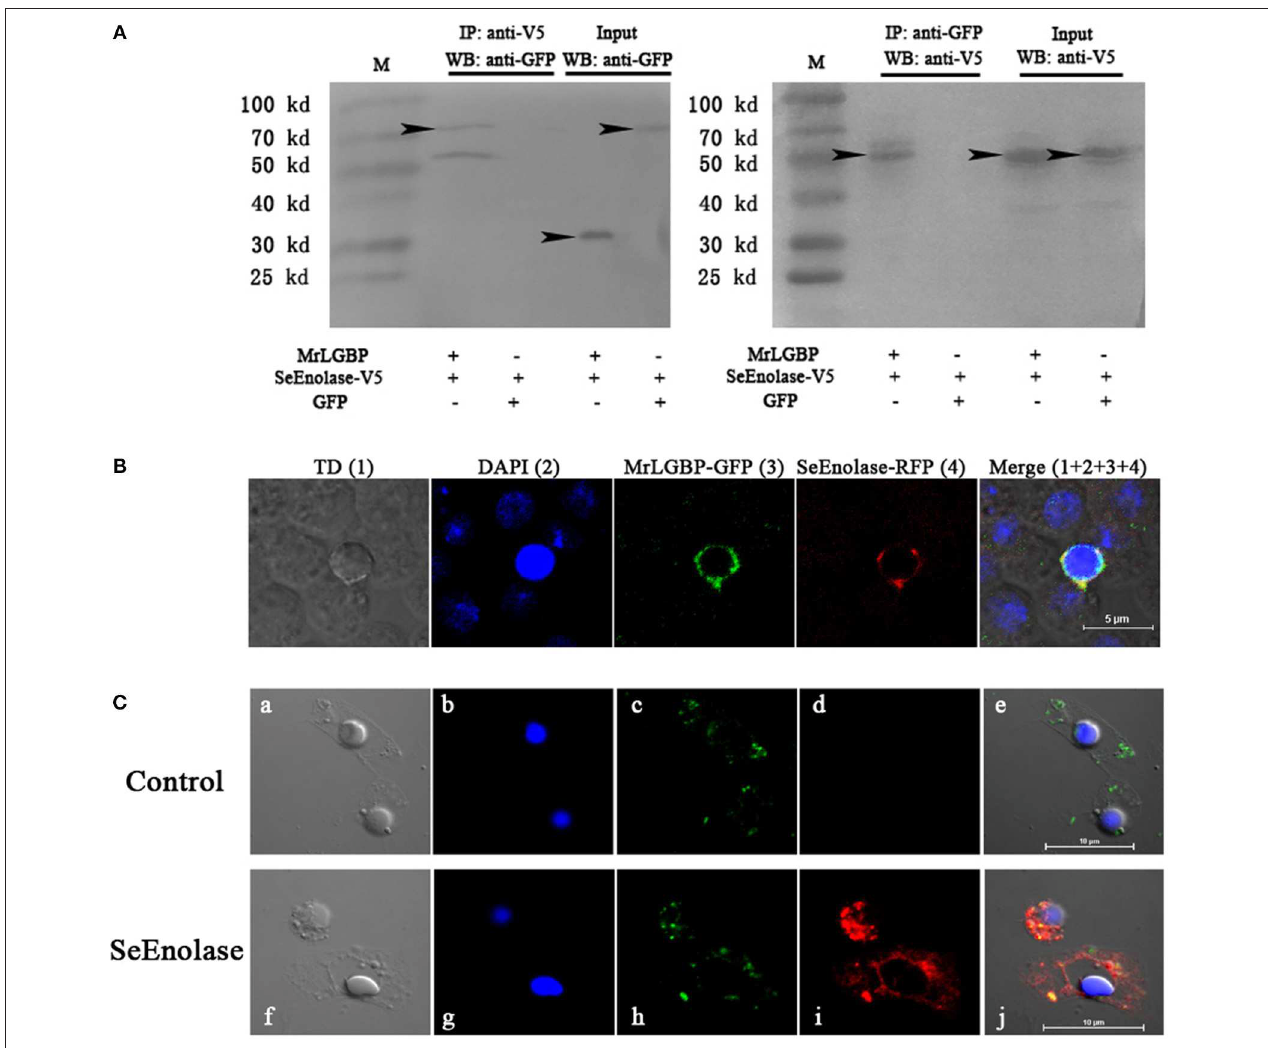
FIGURE 5 | Interaction between MrLGBP and SeEnolase. (A) Co-immunoprecipitation demonstrating that GFP-tagged MrLGBP but not control GFP is co-precipitated with V5-tagged SeEnolase. Immunoprecipitation (IP) and western-blotting (WB) were performed using anti-V5 mouse antibody and anti-GFP rabbit antibodies, respectively. Input: western blotting of the input cell lysates before immunoprecipitation. Approximate molecular sizes: MrLGBP-GFP, ∼ 68 kDa; SeEnolase-V5, ∼ 50 kDa; GFP, ∼ 28 kDa. (B) Subcellular localization of MrLGBP and SeEnolase. Recombinant plasmid of MrLGBP with GFP-tag and SeEnolase with RFP-tag were co-transfected into Drosophila S2 cells. MrLGBP and SeEnolase glowed green and red, respectively. Nuclei were stained with DAPI (blue). Bars = 5 µ m. (C) The co-localization of MrLGBP and SeEnolase in prawn hemocytes analyzed by confocal microscopy. Hemocytes were incubated with SeEnolase protein for 1h. For the control experiment, SeEnolase protein was not included. Hemocytes were incubated with mouse anti-MrLGBP and rabbit anti-SeEnolase as primary antibody, respectively. MrLGBP and SeEnolase stained by Alexa Flour 488 goat anti-Mouse IgG (green) and PE-labeled Goat Anti-Rabbit IgG (red). Hemocytes nuclei were stained with DAPI (blue). Bars = 10 µ m. Hemocytes were visualized by bright field (a,f), blue fluorescence only (b,g), red fluorescence only (c,h), green fluorescence only (d,i), and by bright field merge with all fluorescent molecules (e,j) in both the control and SeEnolase